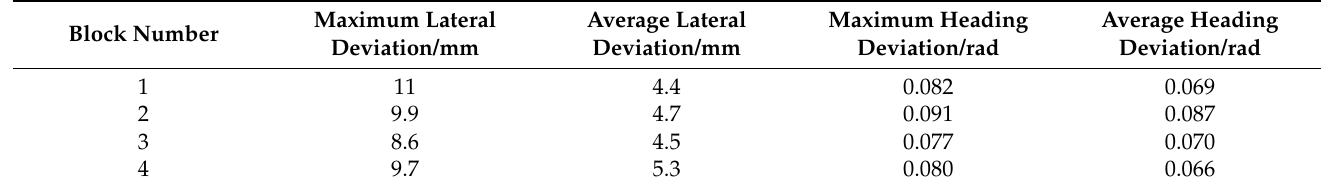
Table 5. Verification test for the lateral deviation and heading deviation statistics.